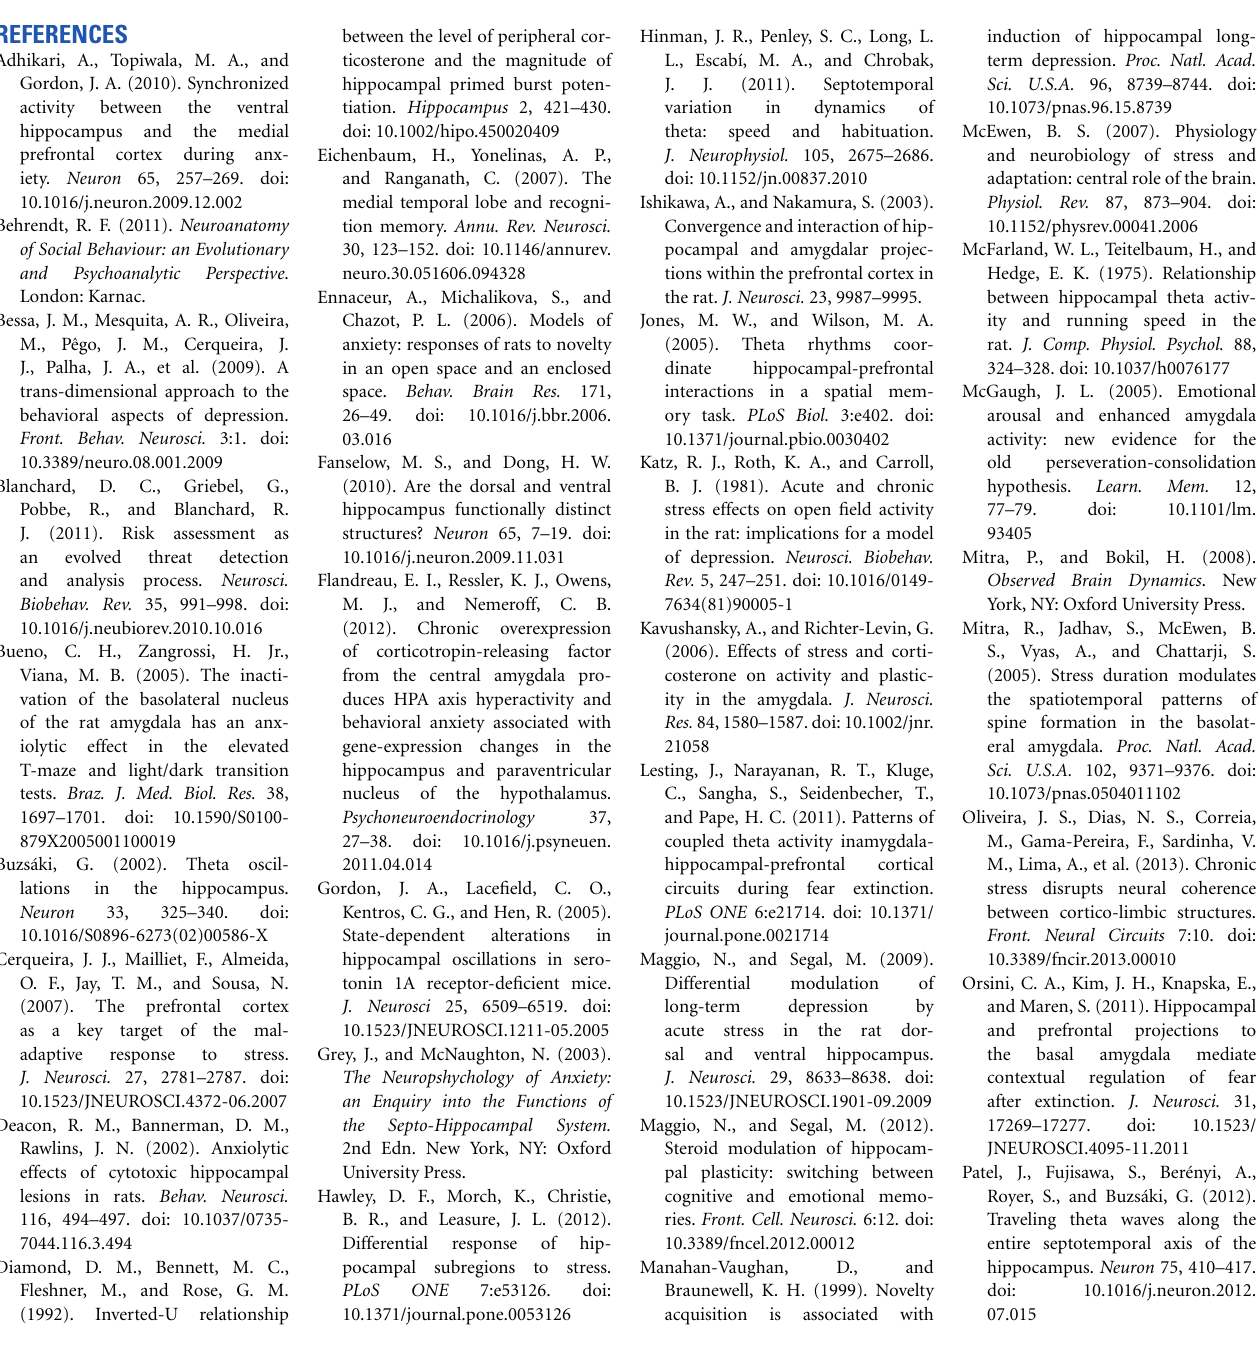
FIGURE S1 | Histological confirmation of electrodes’ positions. (A) Diagrammatic coronal sections of medial prefrontal cortex (mPFC) (left), basolateral amygdala (BLA) (middle-left), dorsal hippocampus (dHPC) (middle-right), ventral hippocampus (vHPC) (right). Sections are arranged from most anterior (top) to most posterior (bottom). Electrolytic lesion